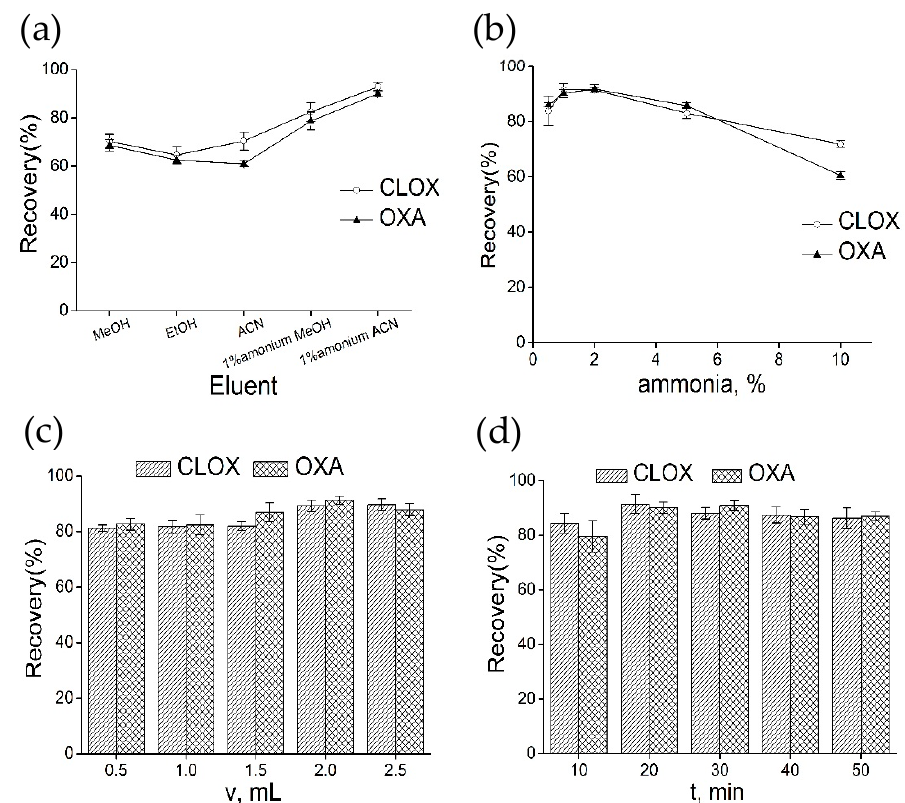
Figure 8. Optimization of the desorption conditions on the recoveries of analytes. ( a ) Effect of elution solvent; ( b ) effect of the content of ammonia in eluent; ( c ) effect of eluent volume; ( d ) effect of desorption time. Conditions: the amount of PPy-PA6-NFsM, 10.0 mg; sample volume, 20.0 mL; concentration of two analytes, 0.5 μ g/mL; pH, 4.0.